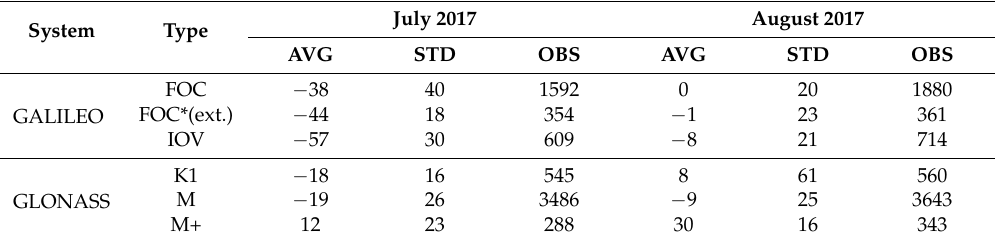
Table 4. SLR residual offset (AVG) and standard deviations (STD) for the period 1 July 2017–31 August 2017. Values are in mm. Abbreviations used: AVG, average; STD, standard deviation; OBS, number of observations.